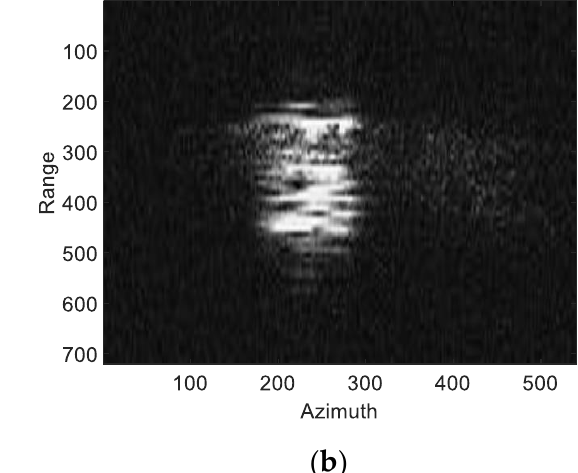
Figure 8. Imaging result of two ship targets from GF-3 measured data with traditional RDA. ( a ) Ship 1; ( b ) ship 2. To obtain the focused SAR images of moving targets, we used the method in [8,17], and the proposed method to image two types of ship targets. The experimental conditions were the same as in Section 4.1.1. The imaging results are shown in Figures 9 and 10. From a longitudinal comparison of Figures 9 and 10, as the sampling ratio decreased, the imag- ing quality of the method in [8,17] gradually decreased. On the contrary, the proposed